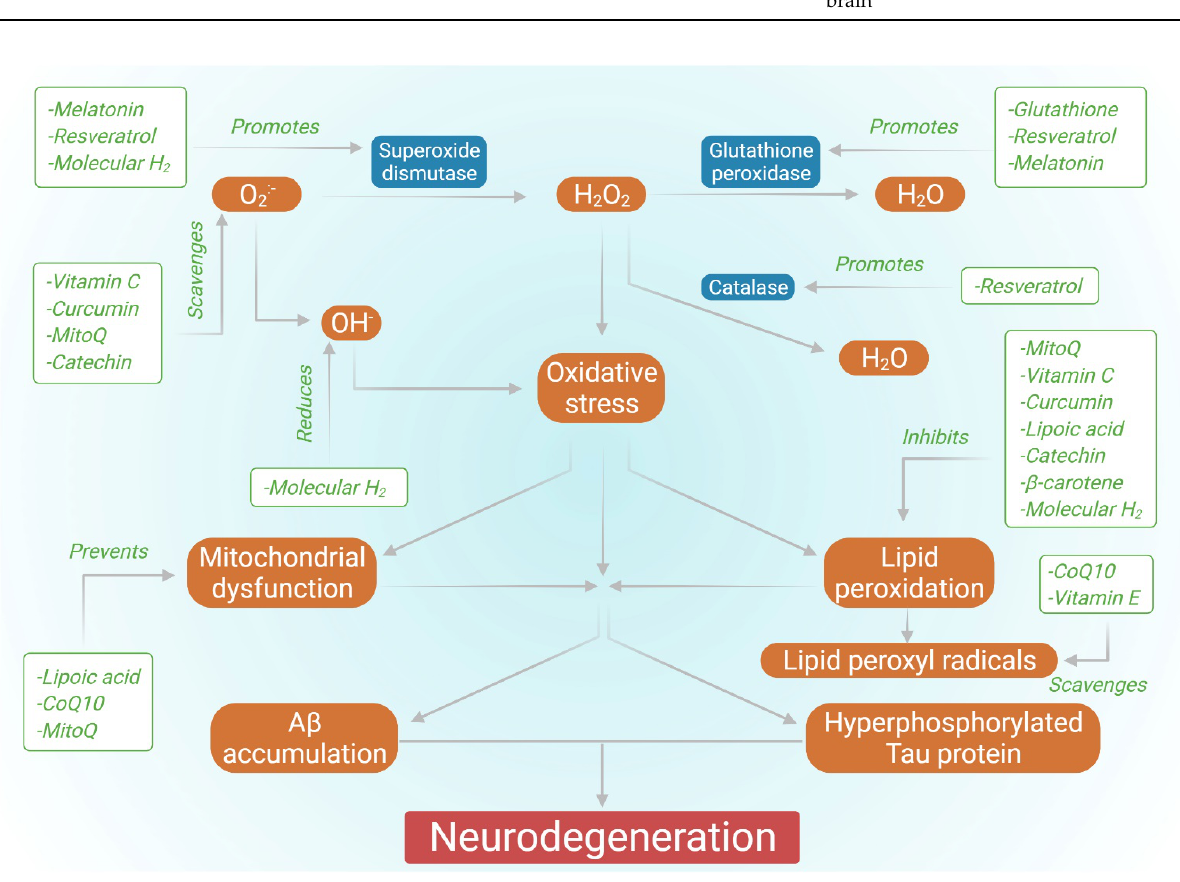
Figure 1. Effect of various antioxidants in countering AD.